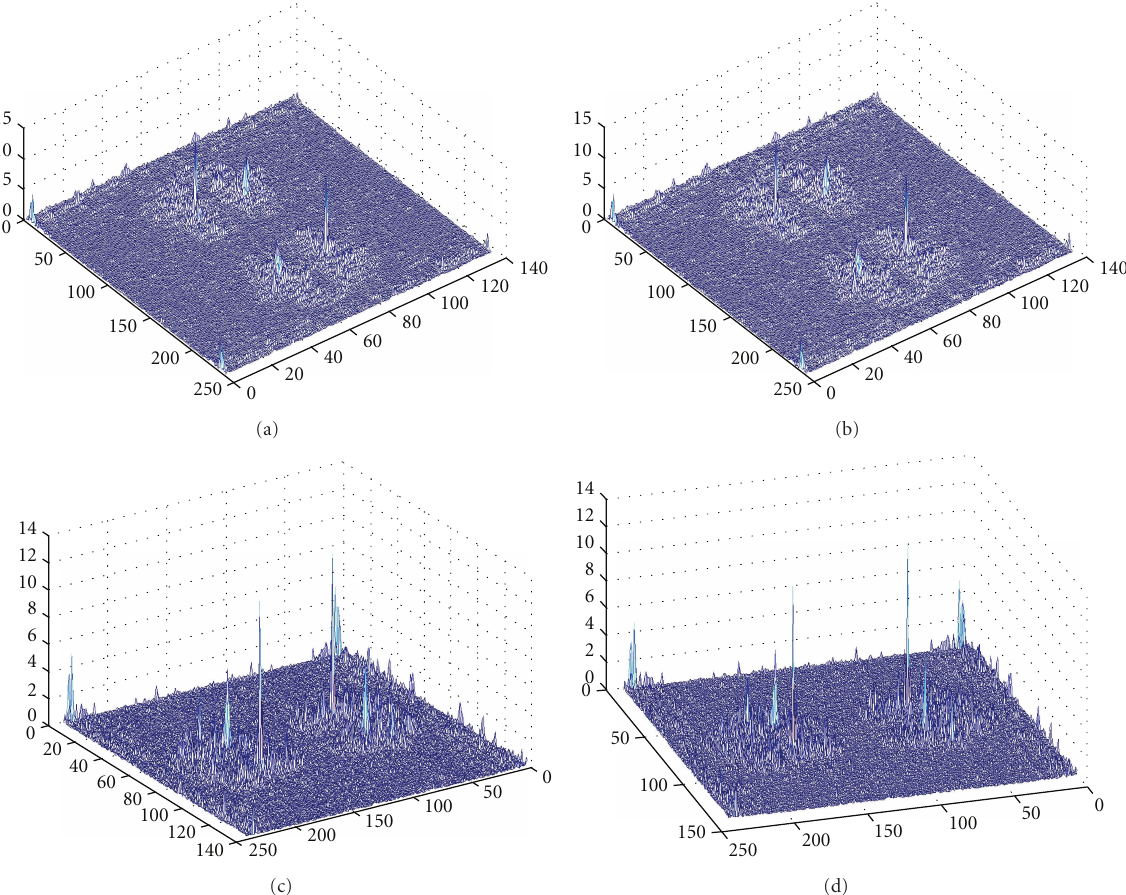
Figure 2: Four di ff erent examples of discriminant phases for di ff erent eyes